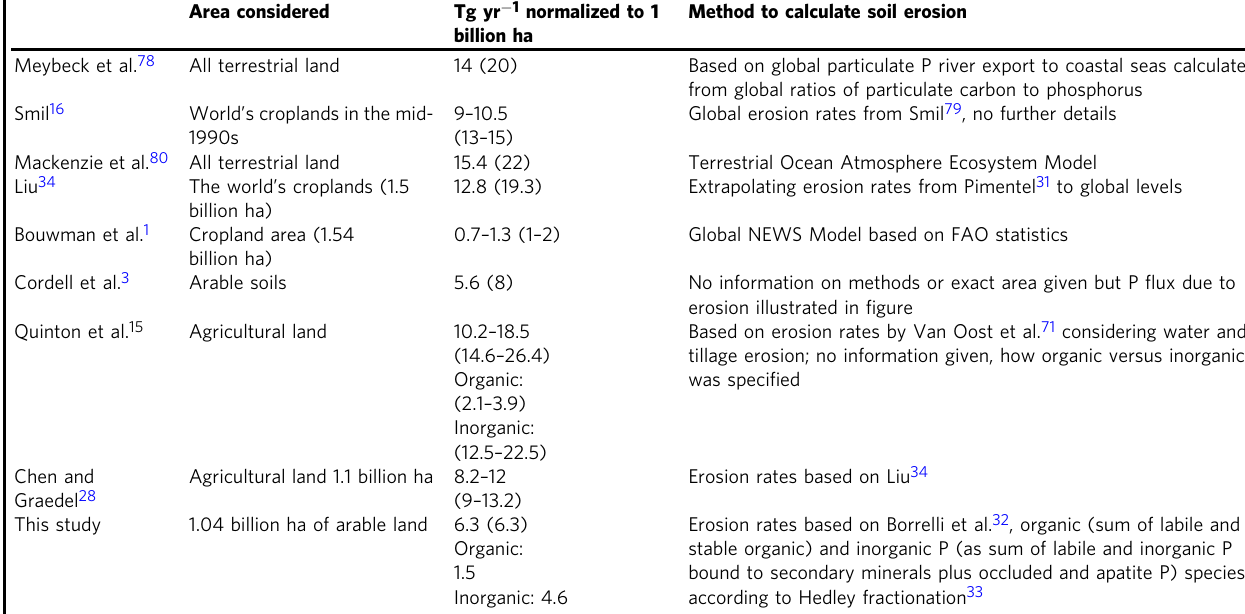
Table 2 Global fl uxes from soils/arable systems to waters as discussed in recent literature. For comparability, all values were normalized to 1 billion ha of arable land (with original values given in